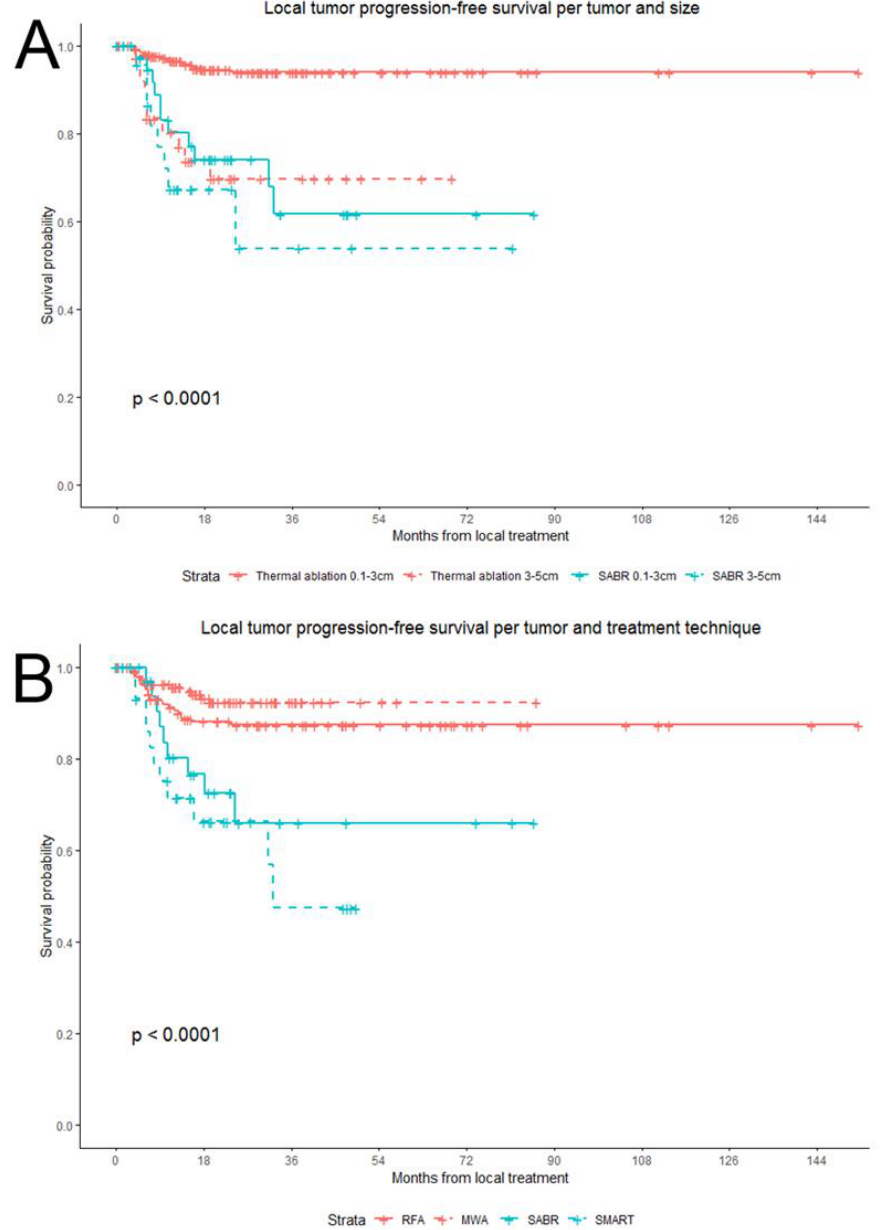
Figure 8. Local tumor progression-free survival curves (LTPFS) following thermal ablation (red) and stereotactic ablative radiotherapy (blue) for unresectable colorectal liver metastases according to subgroup analyses: stratified by CRLM < 3 cm versus 3–5 cm ( A ) and by specific treatment method radiofrequency ablation (RFA), microwave ablation (MWA), conven- tional stereotactic ablative radiotherapy (SABR) and selective MR-guided ablative radiotherapy (SMART) ( B ).